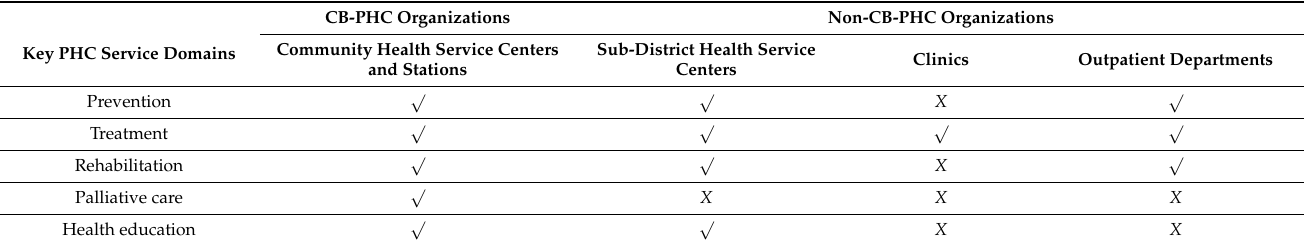
Table 1. Services provided by CB-PHC and non-CB-PHC sectors in urban China.